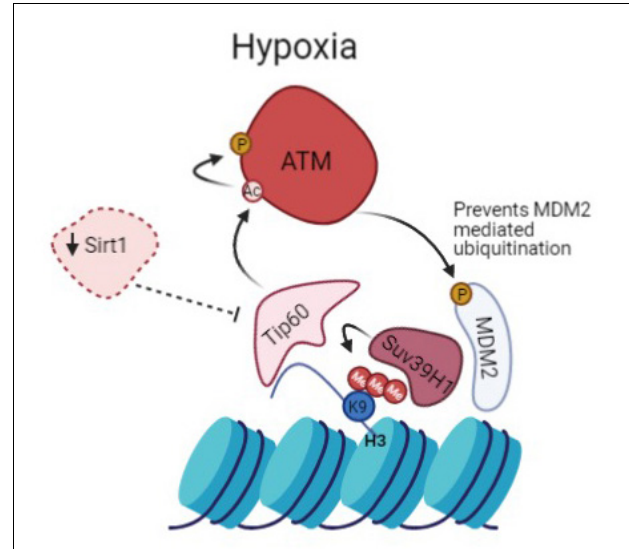
FIGURE 6 | Prolonged activation of ATM in hypoxia promotes heterochromatin formation. Suv39H1 regulates H3K9me3 induction under hypoxia in a MDM2 dependent manner. Hypoxia activates Tip60, enabled by the downregulation of Sirt1. This leads to activation of ATM which negatively regulates MDM2 activity and protein levels allowing upregulation of Suv39H1 and maintenance of H3K9me3 giving rise to a novel positive feedback